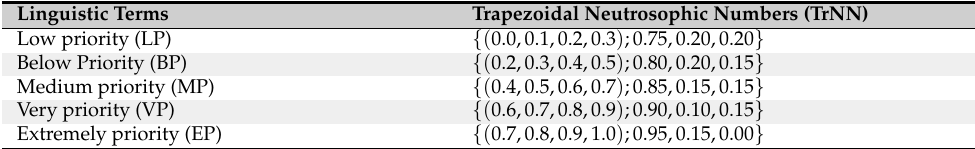
Table 11. Linguistic terms and their corresponding TrNN for rating alternatives.